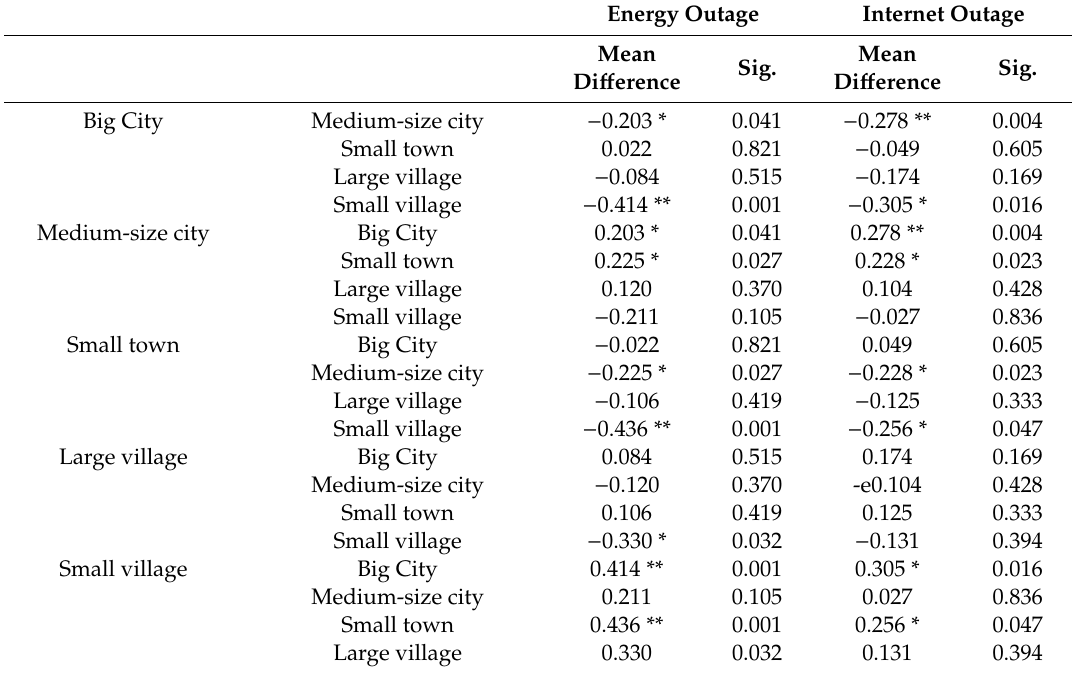
Table 6. Results of LSD post hoc tests. Sig. of the di ff erences in the perceived danger of energy and Internet outage between the categories of town